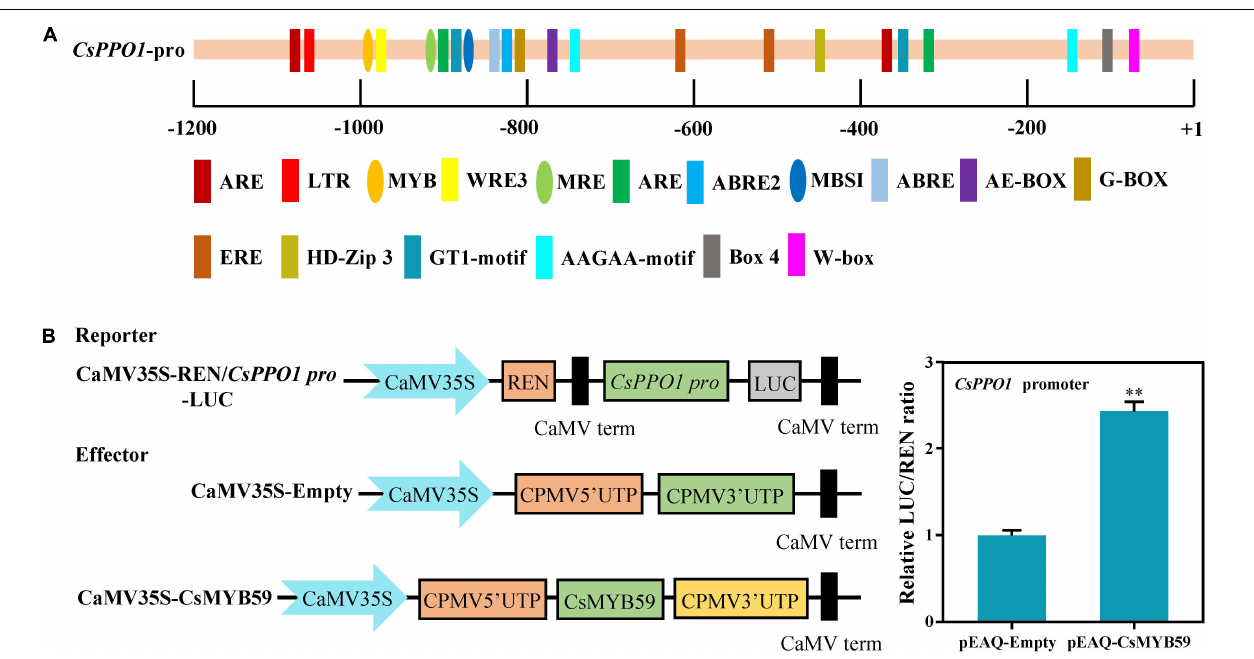
FIGURE 5 | (A) Cis element analysis of CsPPO1 promoter gene. The axis represents the cloned CsPPO1 promoter sequence. Ellipses represent elements that can bind to MYB transcription factors. Rectangles represent other elements. (B) Ability of CsMYB59 to activate transcription of CsPPO1 promoter in Nicotiana benthamiana . The relative REN/LUC ratio of pEAQ-CsMYB59 and pEAQ-empty was calculated to evaluate the transcriptional regulatory effects of CsMYB59 on CsPPO1 promoter. ∗∗ represents significant difference at P < 0.01. LUC, luciferase; REN, Renilla